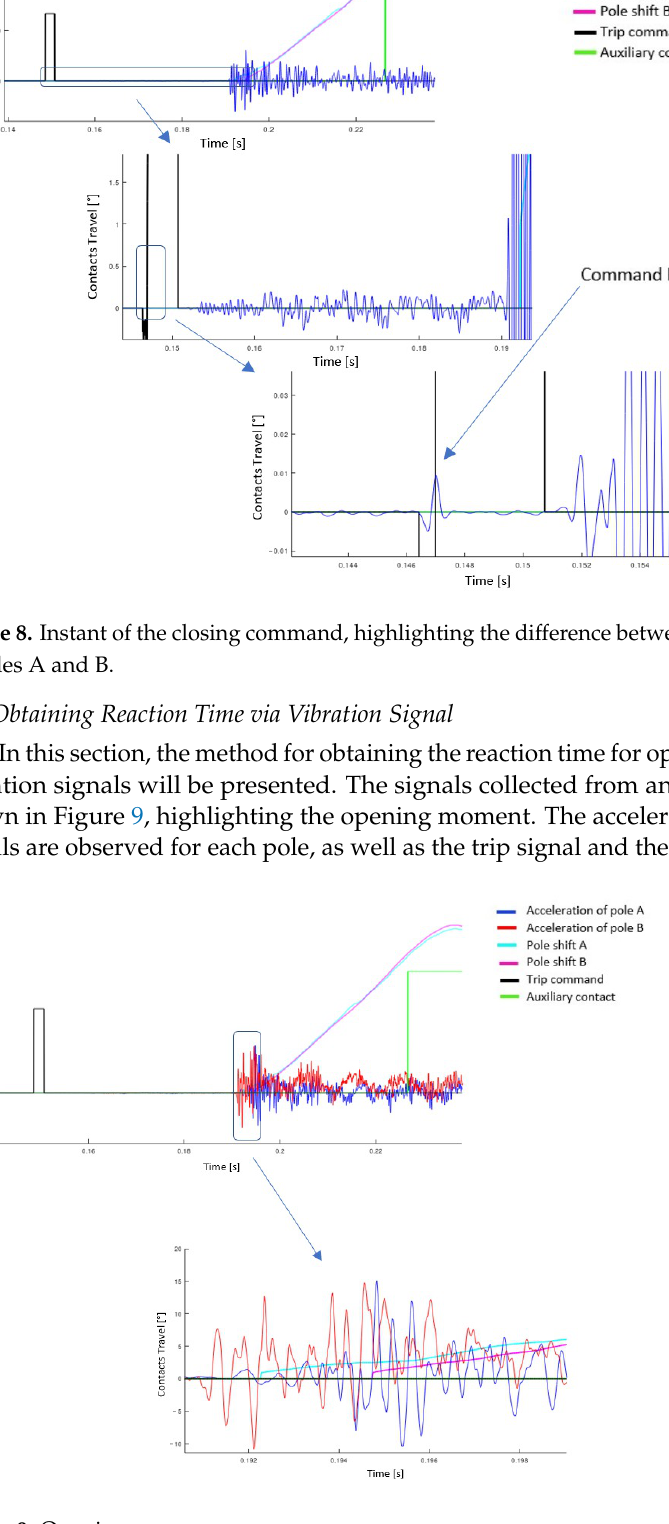
Figure 9. Opening